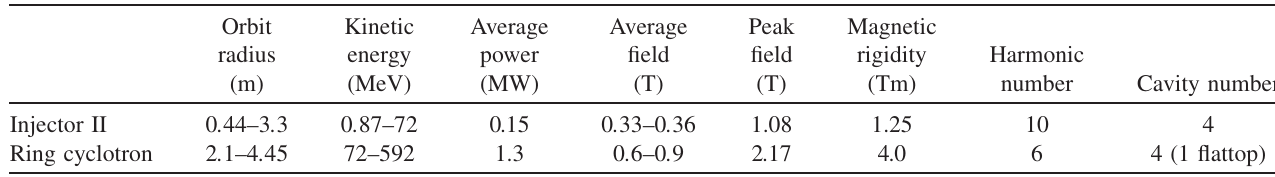
TABLE I. Key parameters of the two sector cyclotrons.